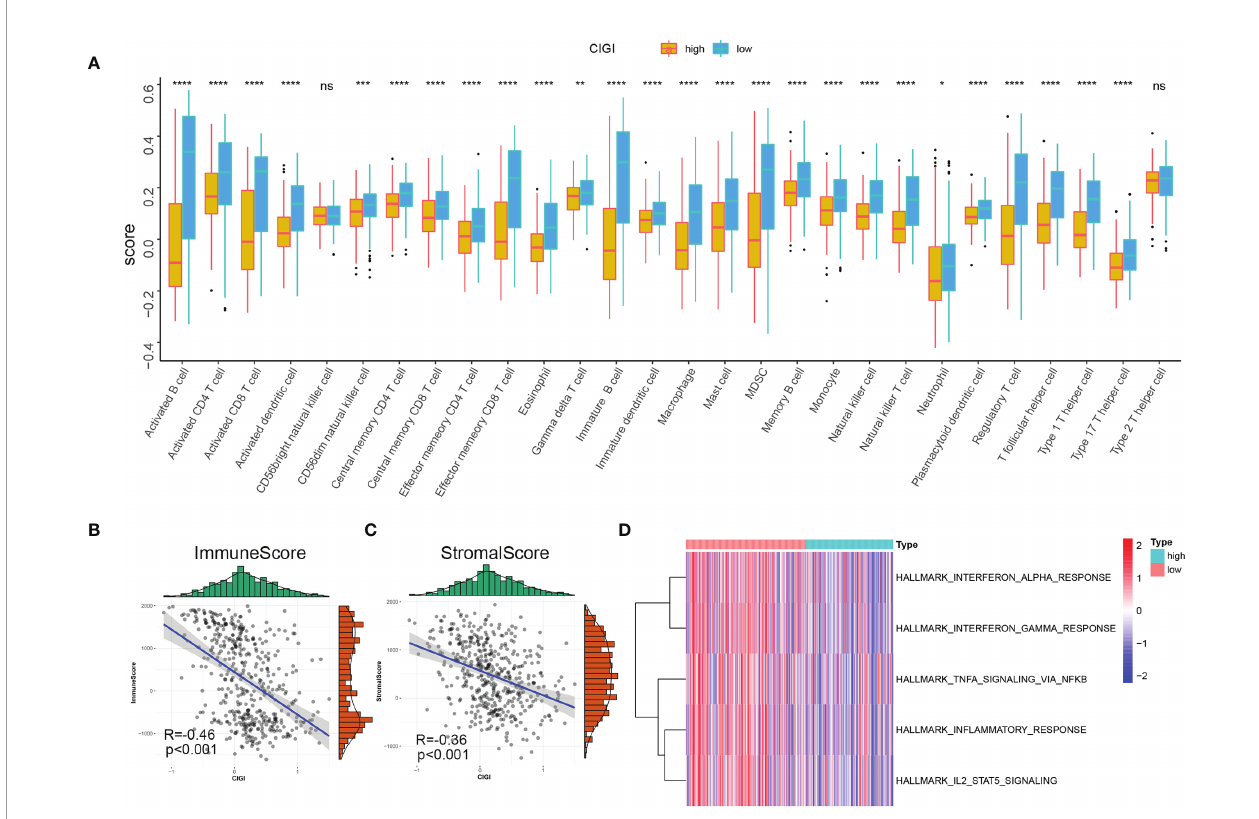
FIGURE 8 | Immune Pro fi le in CIGI. (A) Distribution level of 28 types of immune cells in the high- versus low-CIGI group. (B, C) Correlations between CIGI and Immune (R = -0.46, p < 0.001) and Stromal (R = -0.36, p < 0.001) scores. (D) Immune-related pathways with differential expressions between the high- versus low-CIGI group. *p < 0.05, **p < 0.01, ***p < 0.001, ****p < 0.0001. ns, no signi fi